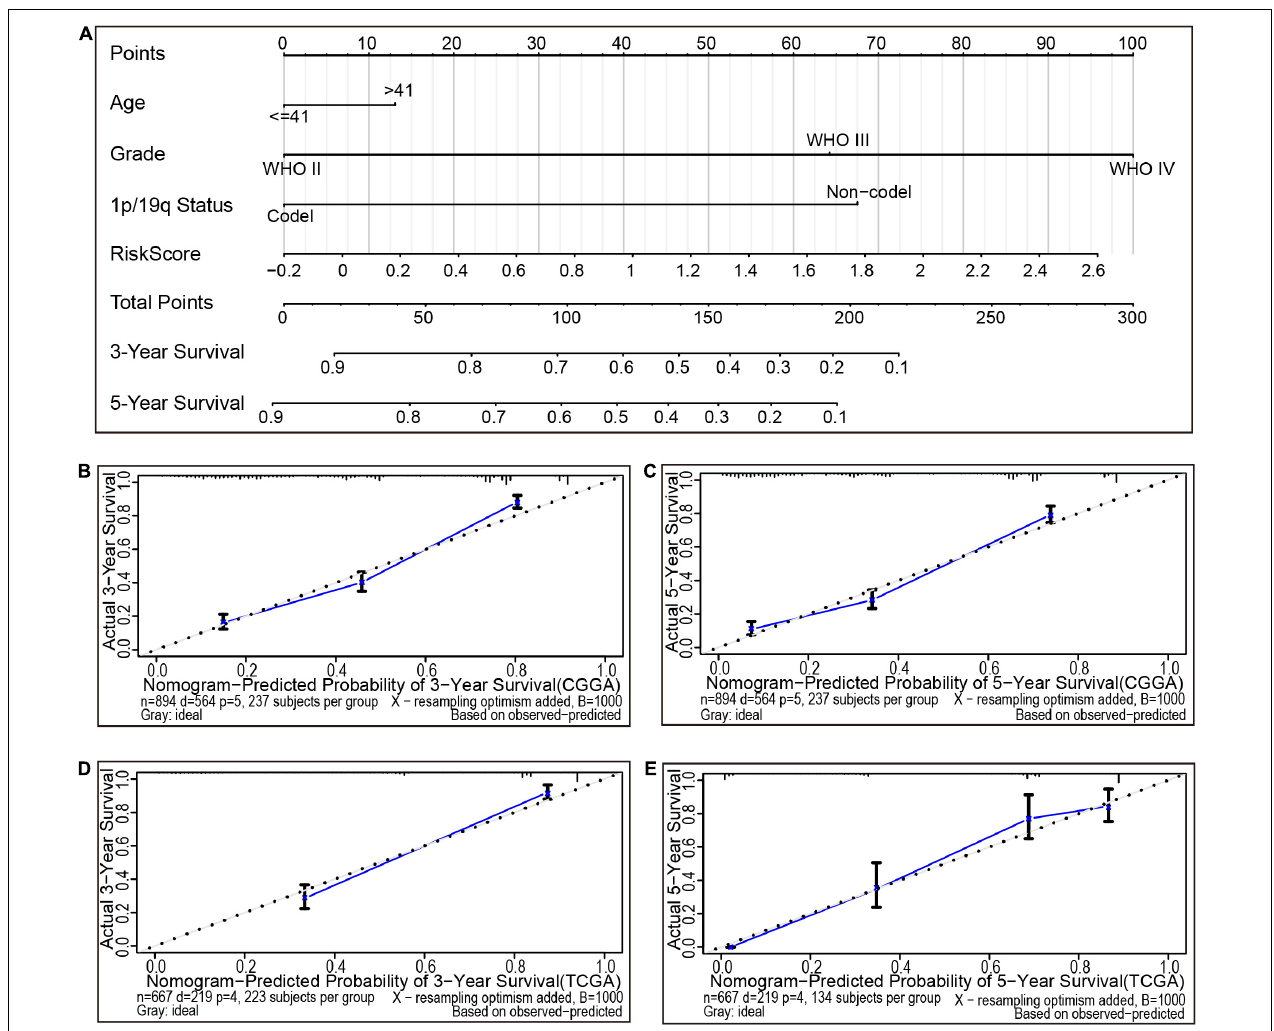
FIGURE 5 | The nomogram can predict the prognosis of gliomas. (A) A nomogram of the gliomas cohort (training set) was used to predict overall survival. (B,C) A calibration plot was used to predict the 3-year (B) and 5-year survival (C) in the CGGA cohorts (training set). Calibration plots for 3-year (D) and 5-year survival (E) in the Cancer Genome Atlas (TCGA) cohort (testing set). The X- and Y-axis represent the Nomogram prediction and actual survival, respectively. The solid line represents the nomogram of the forecast and the vertical line represents the 95% confidence